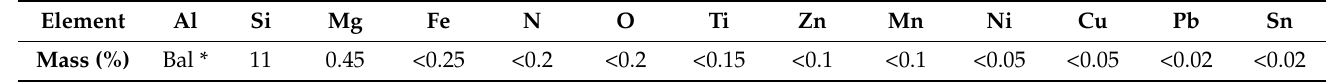
Table 1. Chemical composition of the feed material AlSi10Mg